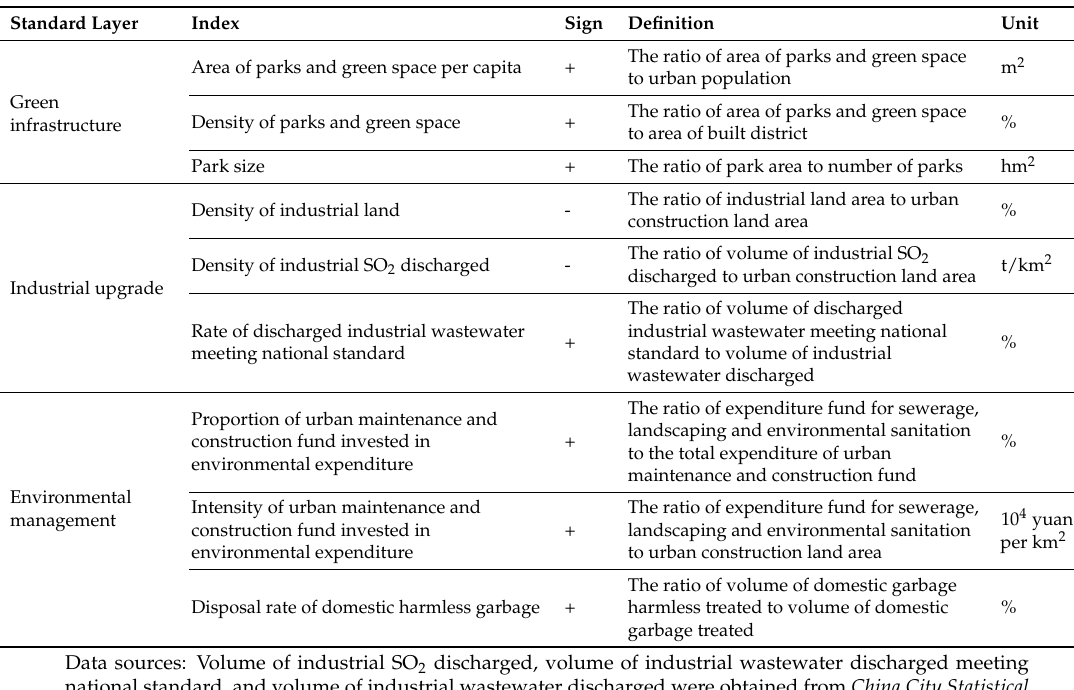
Table 1. Assessment index system of environmental benefits of urban land